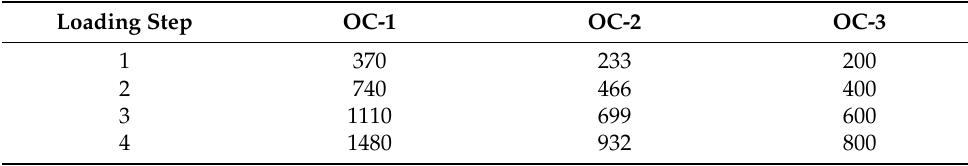
Figure 24. Photographs of the static loading test. ( a ) Full-span; ( b ) Half-span. Table 4. Loading values for the full-span loading test (unit: N).